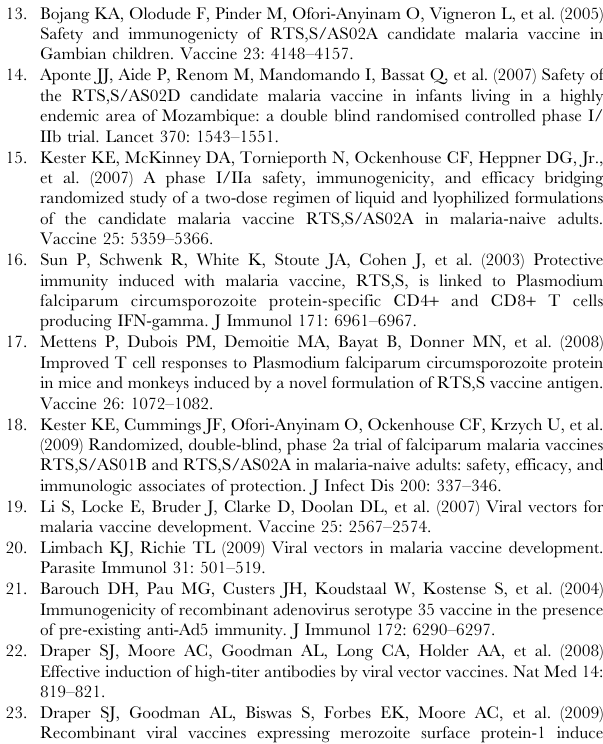
Table S1 Unsolicited adverse events experienced by volunteers Days 0–28. Unsolicited adverse events were recorded for 28 days following each immunization. Because of the theoretical, even if remote, possibility of reversion of the vaccine to replication competence, attention was paid to unexpected symptoms that might have reflected adenovirus infection. However, the few clinical syndromes observed in volunteers following immunization that were consistent with adenovirus infection (upper and lower respiratory infection, enteritis, urinary tract infection) bore no particular relationship to immunization in terms of timing and appeared to reflect background rates in the community.